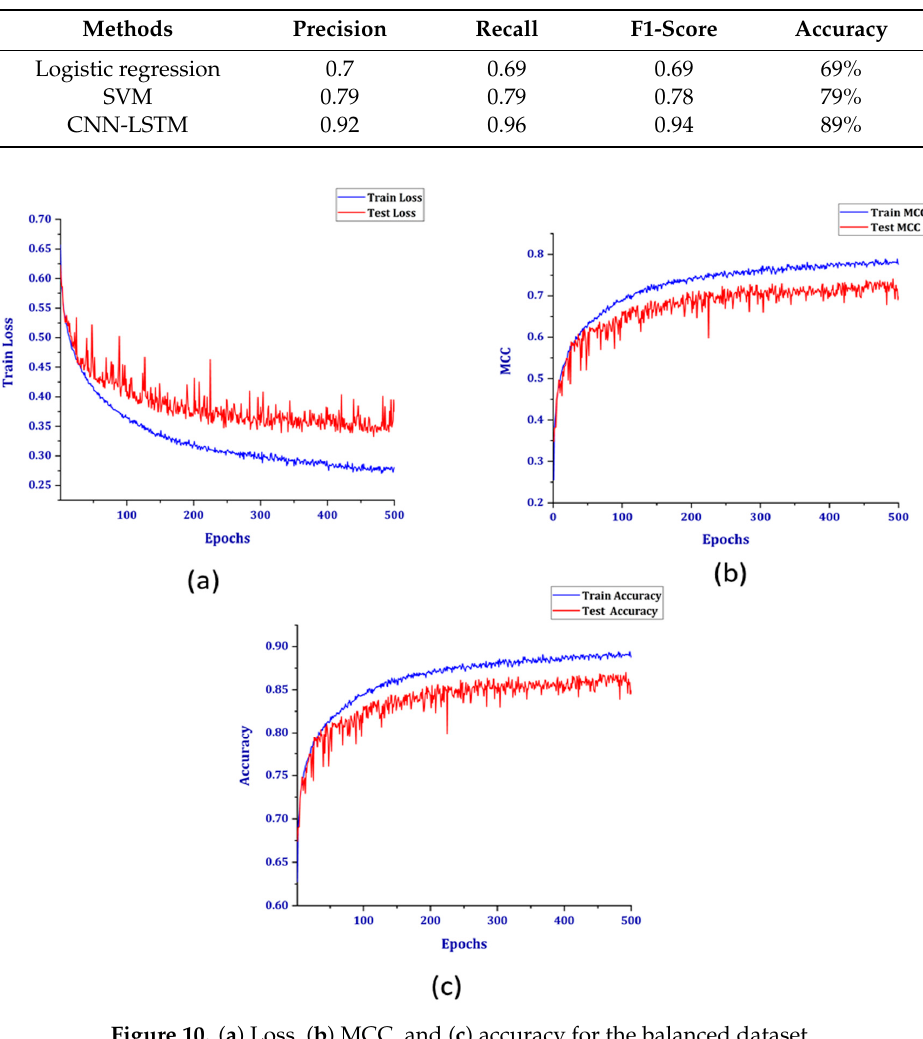
Figure 10. ( a ) Loss, ( b ) MCC, and ( c ) accuracy for the balanced dataset.